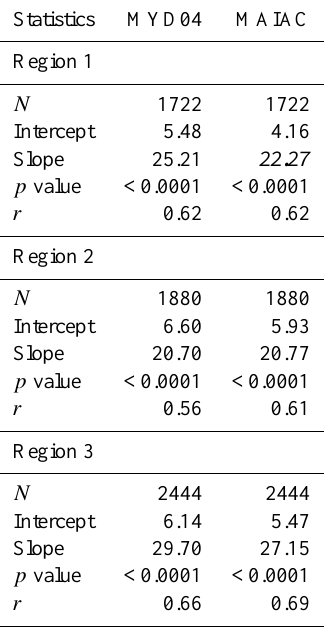
Table 1. Direct comparison between coarse MYD04 AOD 10km and fine-resolution MAIAC 1km AOD for the same days and loca- tions separately for each of geographic